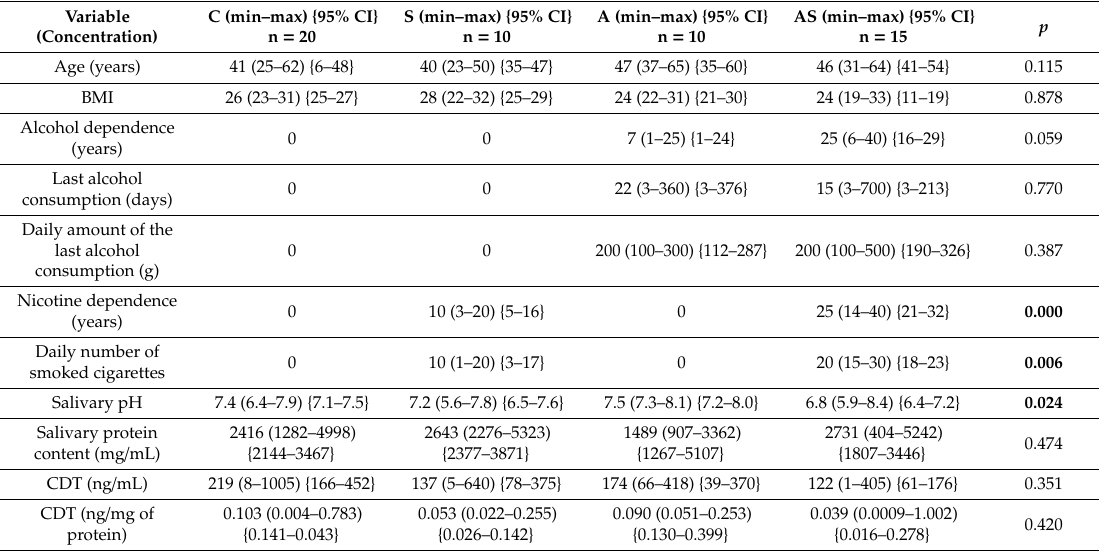
Table 1. Group characteristics and salivary parameters (pH, protein content, carbohydrate-deficient transferrin (CDT)) in healthy social drinkers (C group), chronic cigarette smokers (without harmful alcohol use / dependence; S), alcohol-dependent non-smokers (A), and alcohol-dependent smokers